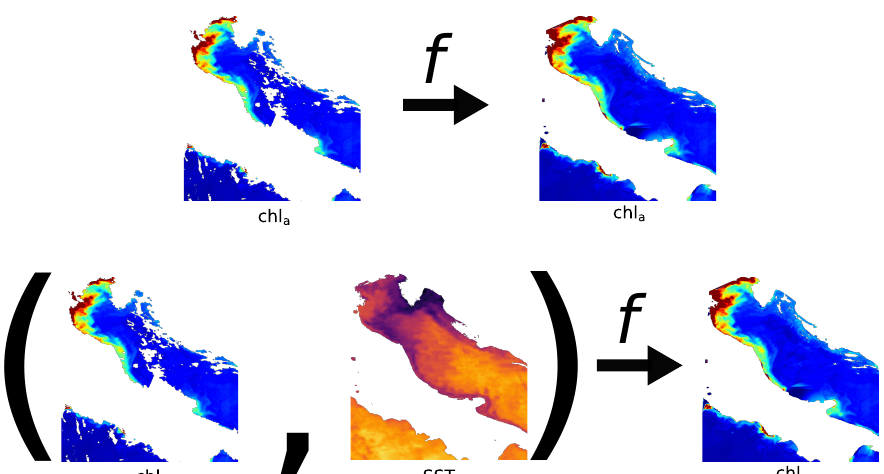
Figure 2. Examples of univariate and multivariate reconstruction approaches. In both cases, chl a is the target data x . Missing data in this case were caused by rough sea surface. The top row exemplifies the non-proxy approach. The bottom row exemplifies the proxy approach, where SST has been taken as proxy data y . Both examples imply available data have been composited with reconstructed missing data to obtain complete data, x ( r ) = x ( r a ) ⊕ x ( r m )